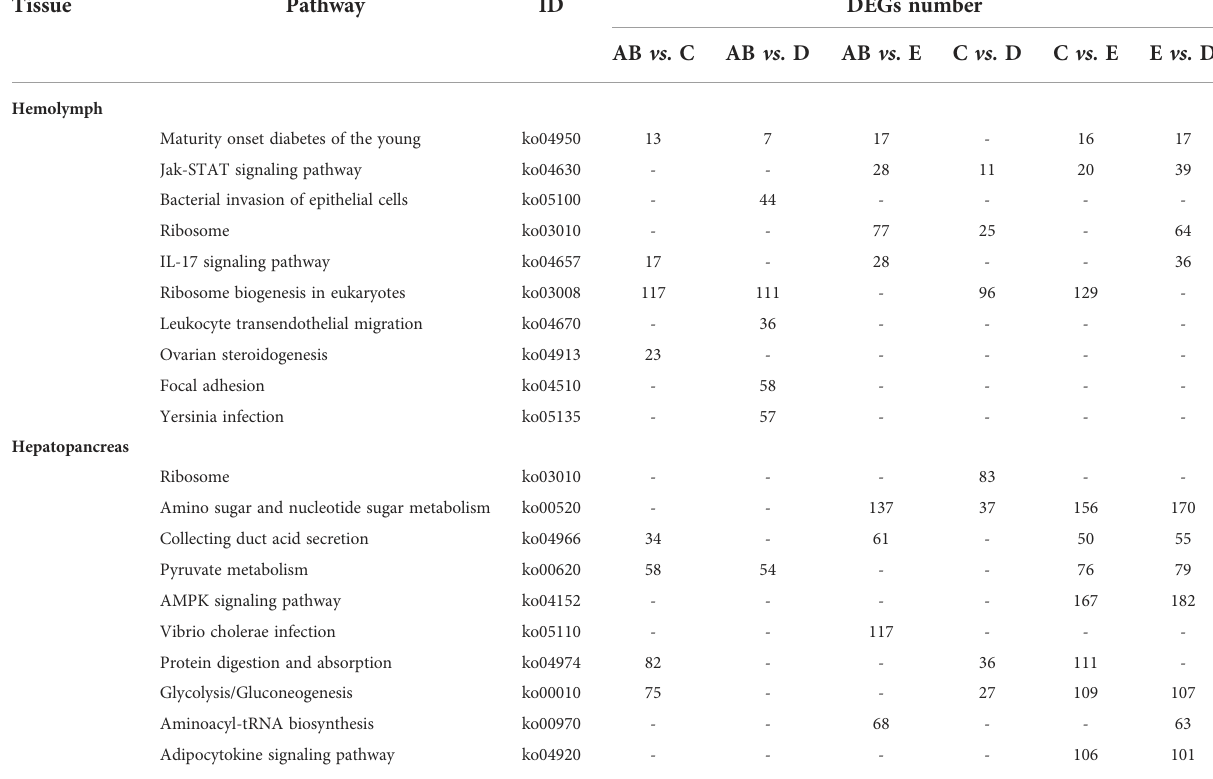
TABLE 4 Signi fi cantly changed pathways obtained with KEGG, using the signi fi cantly changed genes from hemolymph and hepatopancreas during the molt cycle of P. trituberculatus . Tissue